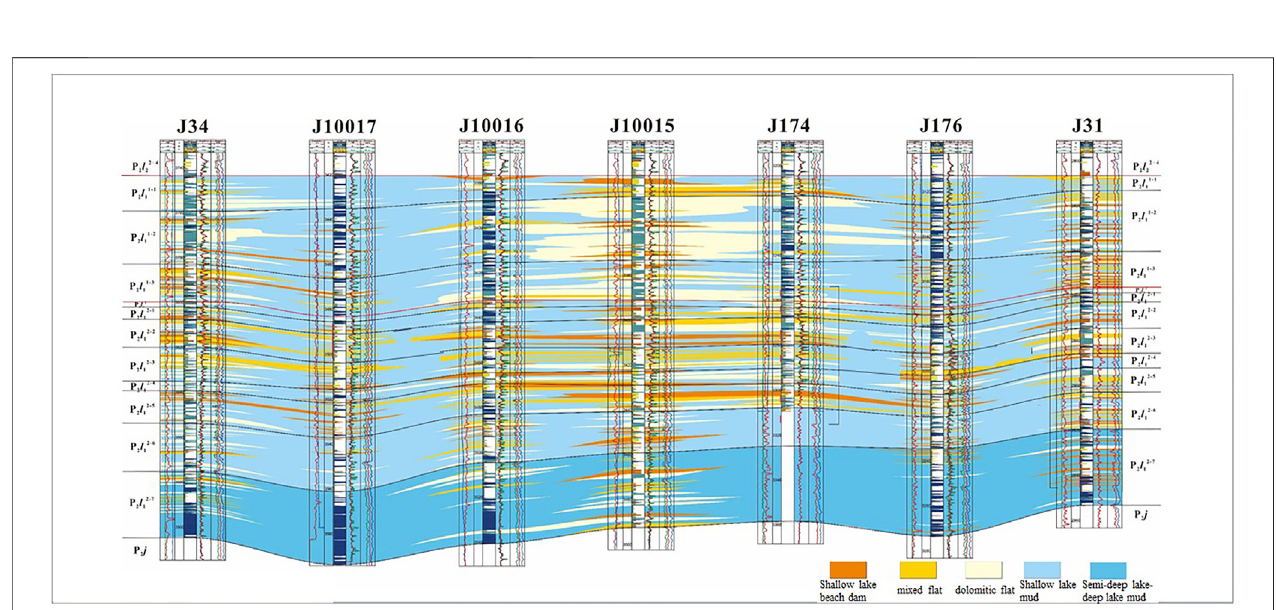
FIGURE 5 | Pro fi le facies of J34~J10017~J10016~J10015~J174~J76~J31 wells in the upper sweet spots of the Lucaogou Formation in the Jimsar Sag.